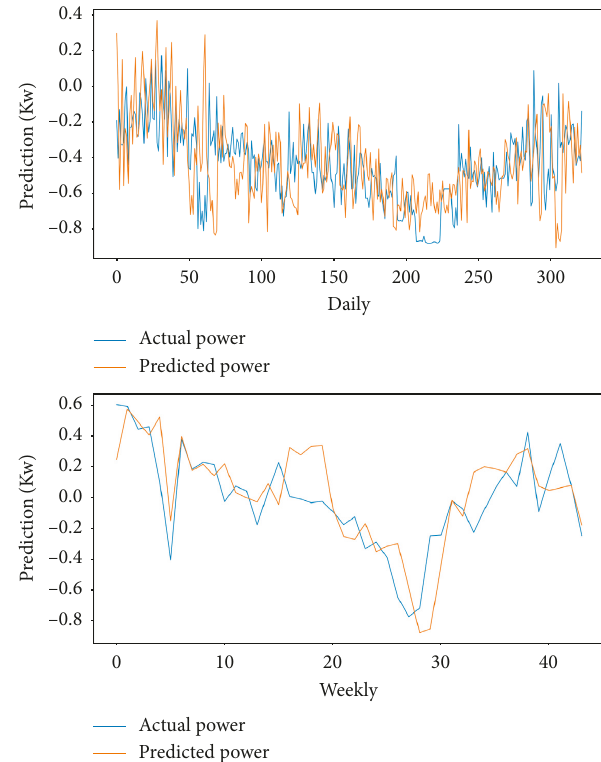
Figure 5: Visual representation of GRU-based forecasting results considering minute and hour horizons on the household power dataset.